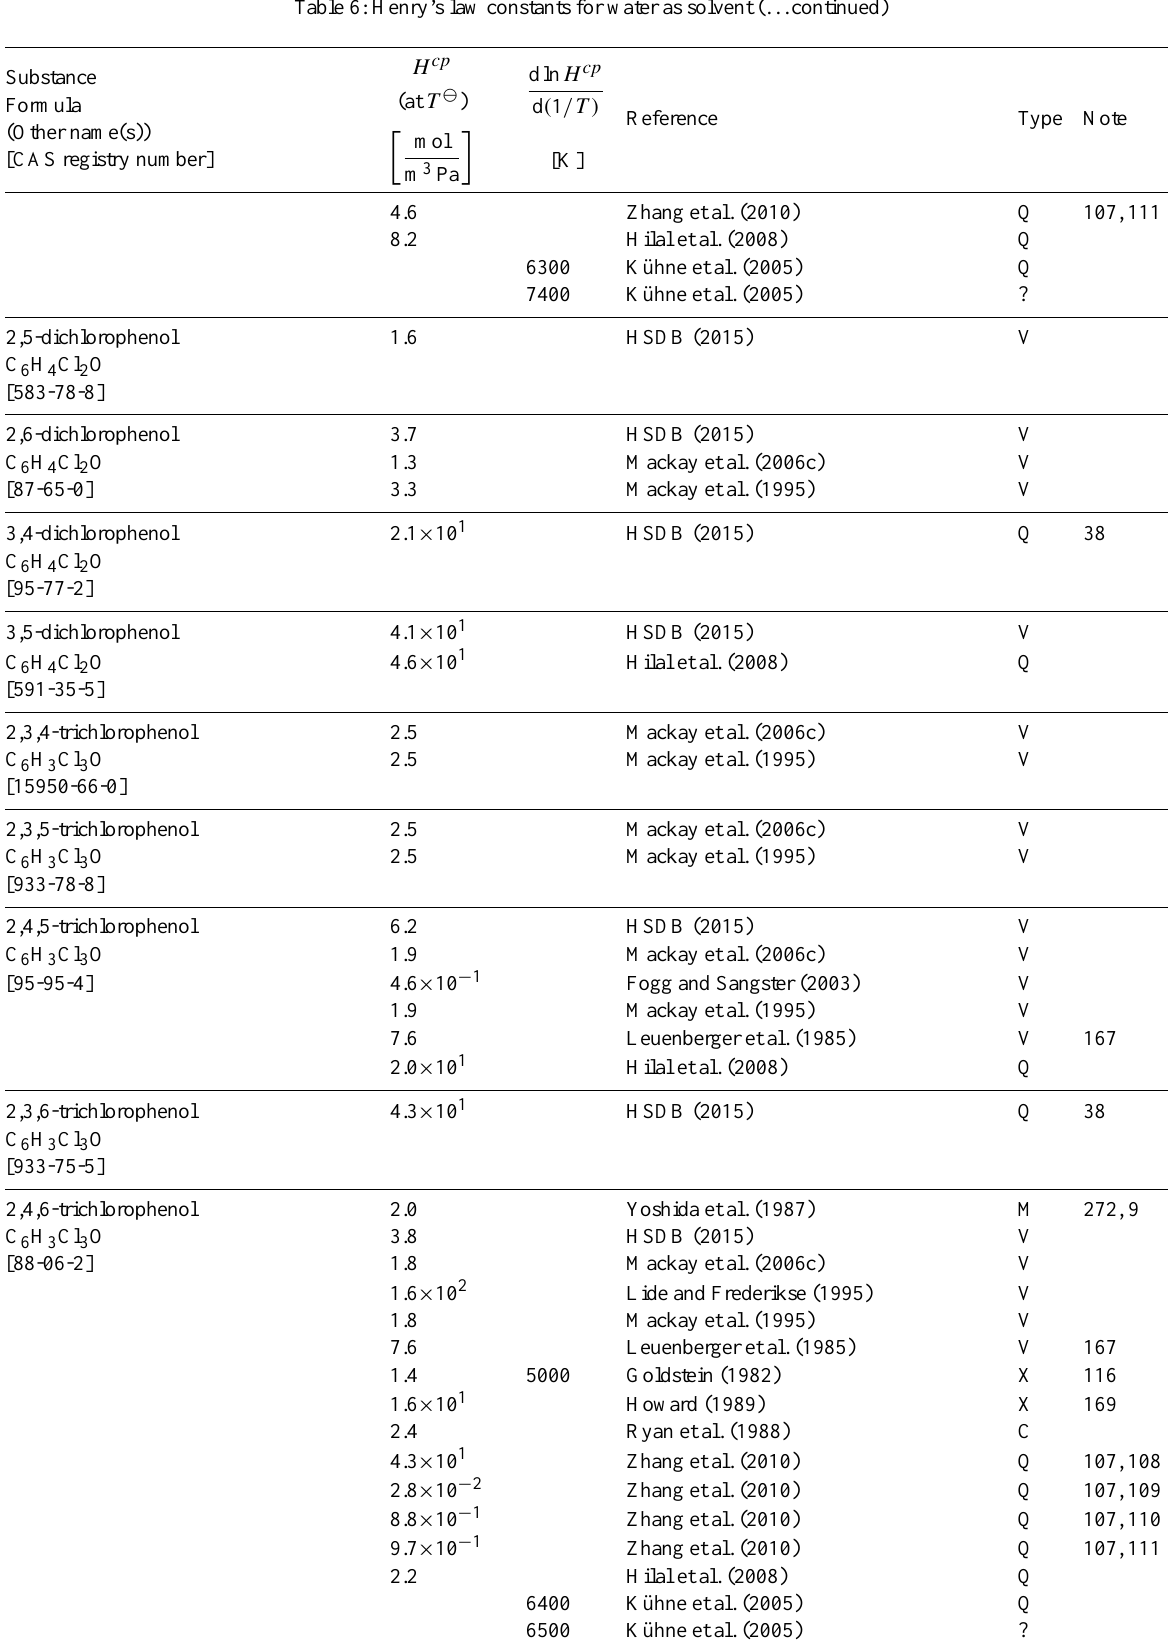
Table 6: Henry’s law constants for water as solvent